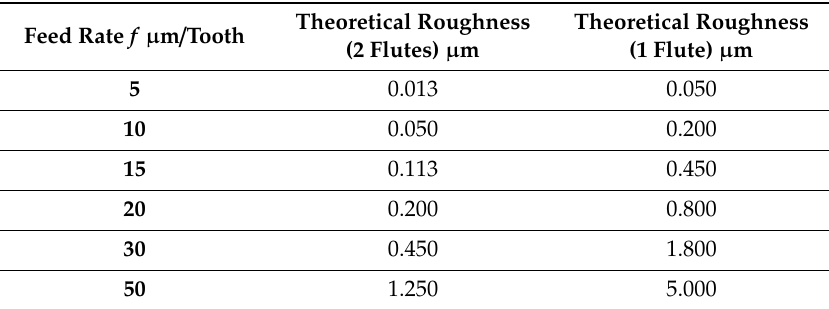
Table 2. Theoretical roughness.